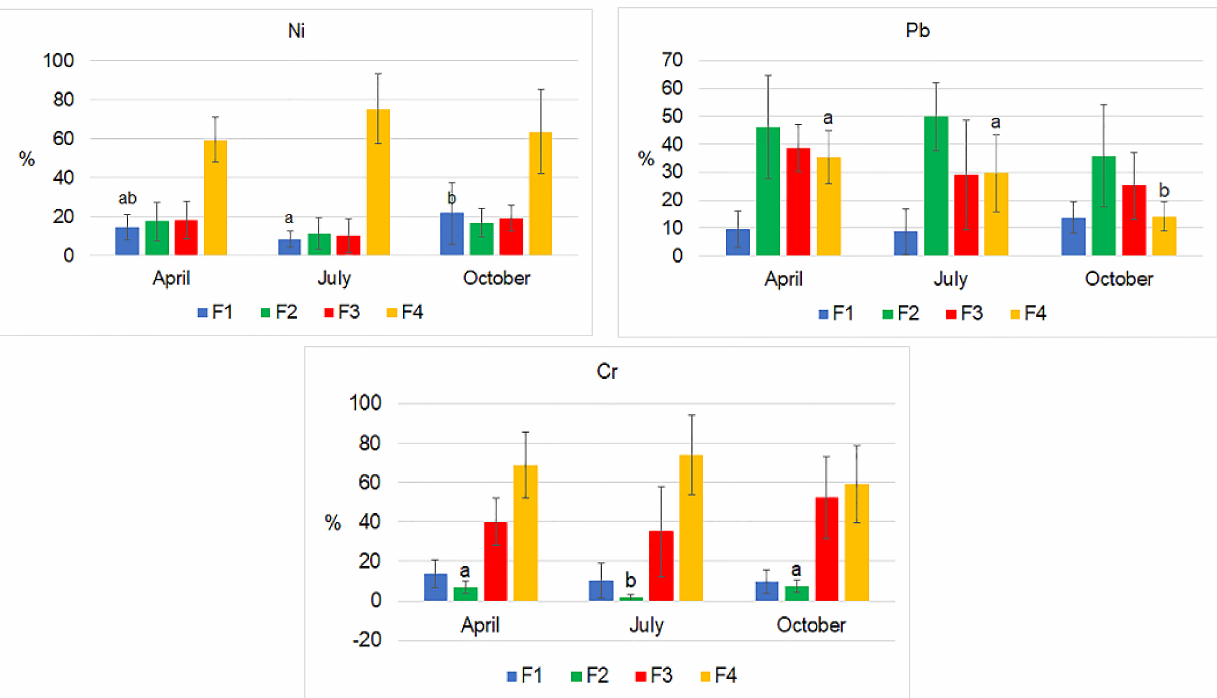
Figure 3. Seasonal changes of fractional composition of metals. Different letters above bars (mean ± standard deviation) indicate significant difference (P <